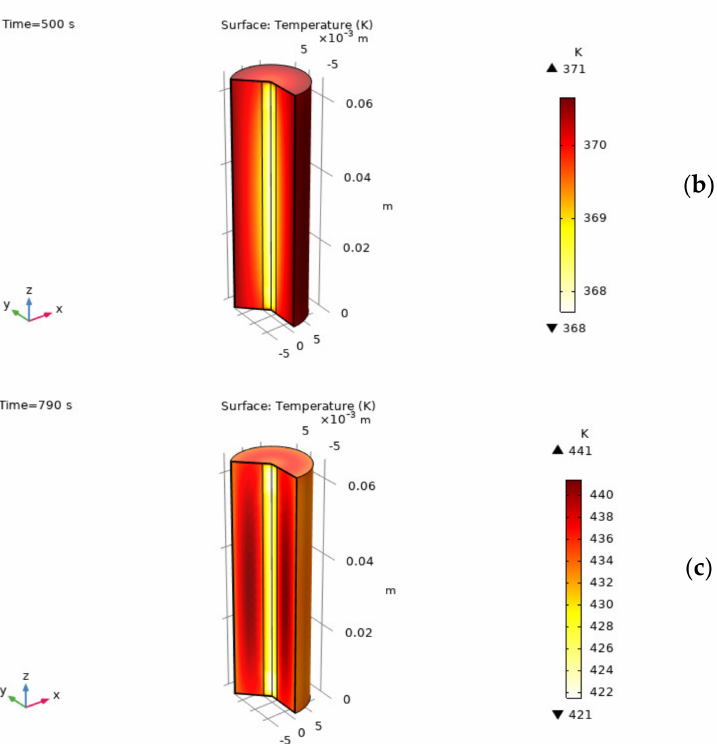
Figure 18. Temperature distribution inside an LCO cell exposed to an external heat flux: ( a ) at the end of the first charging phase; ( b ) at the end of the first full charging-discharging cycle; and ( c ) at the ignition